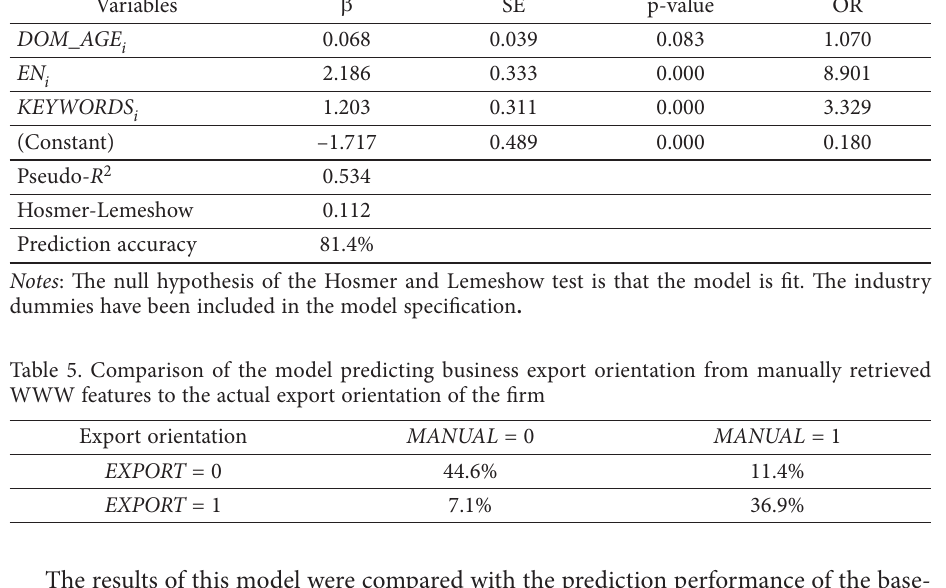
Table 4. Prediction of export orientation with manually retrieved WWW variables Variables